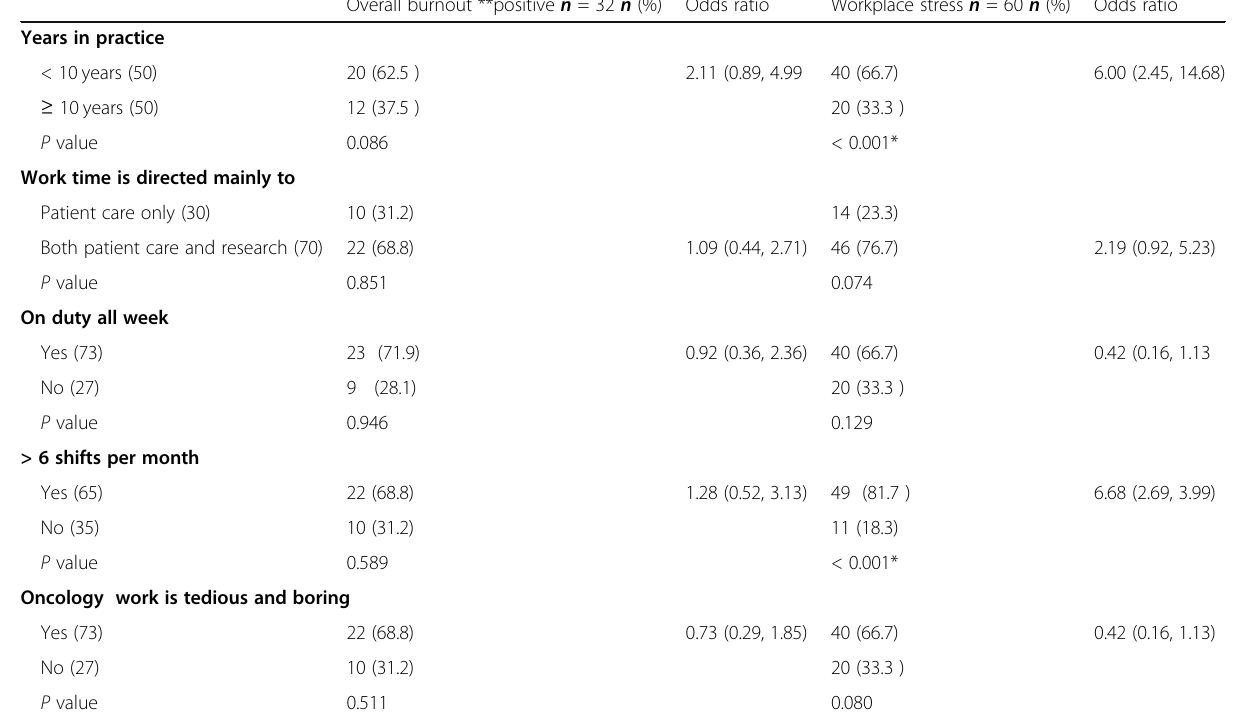
Table 5 Relation of burnout subscales and workplace stress to working conditions of the studied